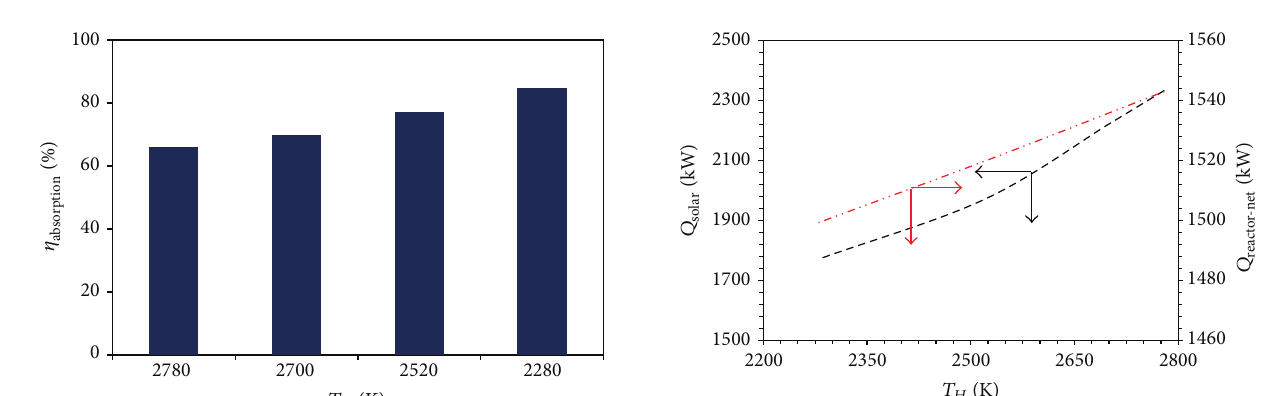
. Figure 7: Effect of absorption